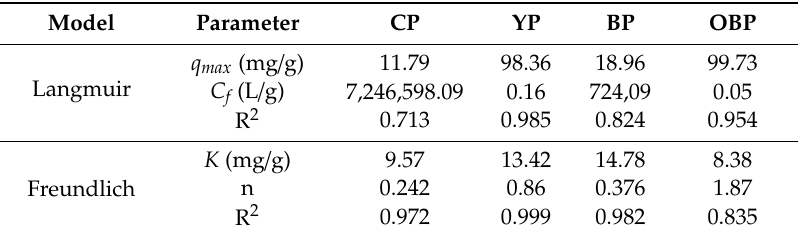
Table 7. Fitting parameters for isotherm